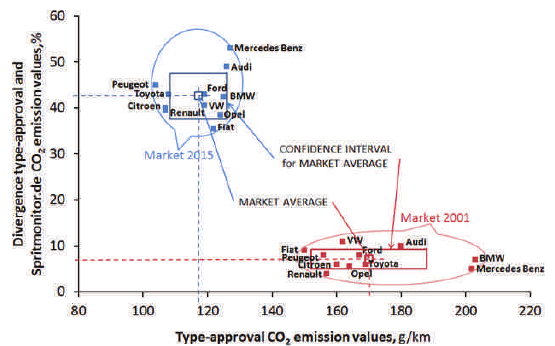
Fig. 2. Test results of carbon dioxide emission in comparison with emis- sion in natural operation (based on